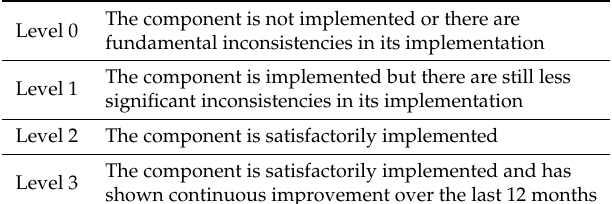
Table 3. Scale for measuring level of satisfaction in comparison to best practices.